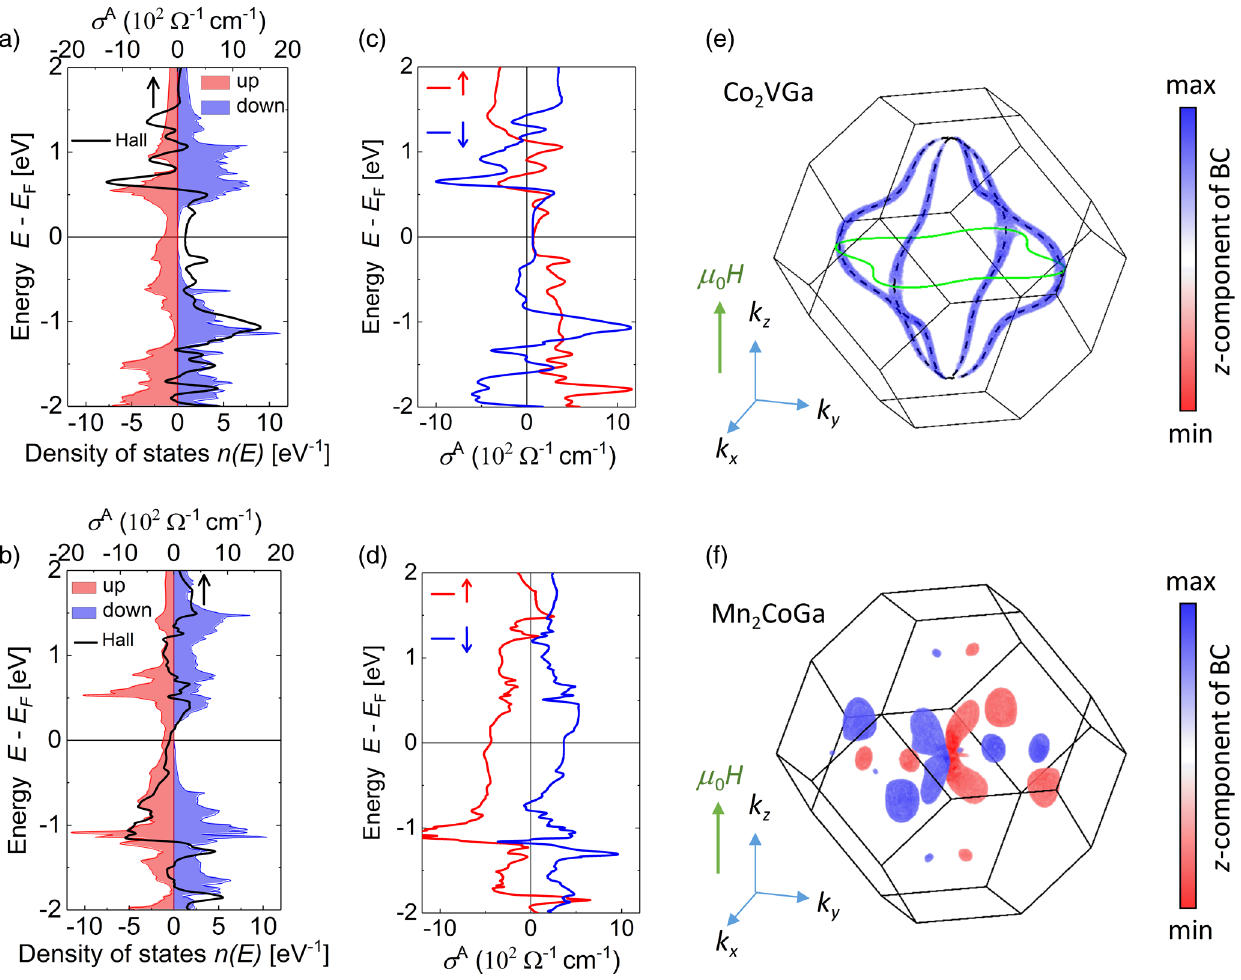
FIG. 4. Computed spin-resolved DOS for (a) Co 2 VGa and (b) Mn 2 CoGa. Black lines represent the calculated net anomalous Hall conductivity ( σ A ) values. Red and blue represent the DOS for the majority and minority carriers, respectively. Hall contributions in the majority and minority spin channels for (c) Co 2 VGa and (d) Mn 2 CoGa. Berry curvature distribution in the BZ for (e) Co 2 VGa and (f) Mn 2 CoGa calculated for all valence bands. The solid green line in (e) represents the protected nodal line due to the M z symmetry operation with magnetic field along z direction. The dotted black lines are the gapped nodal lines which the Berry curvature (BC) distribution in Co 2 VGa